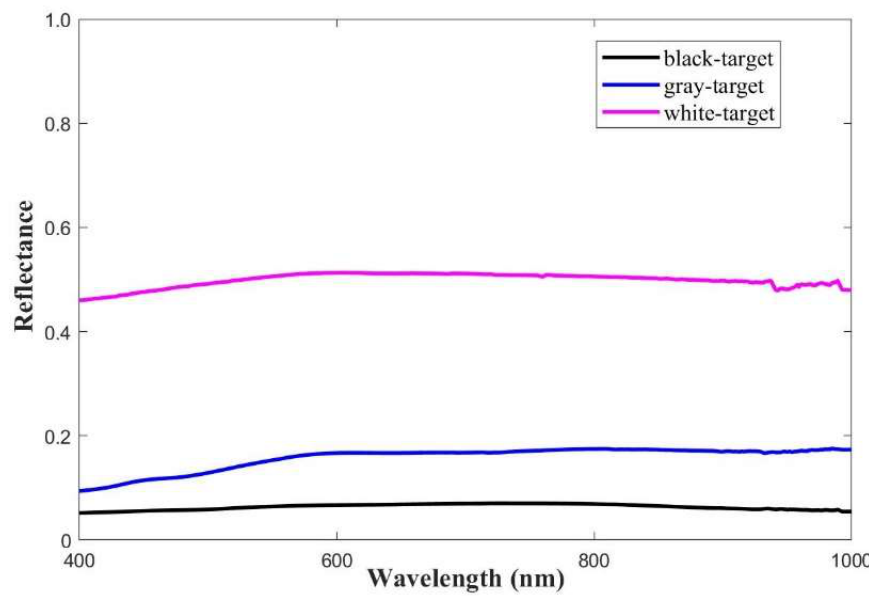
Figure 8. Spectral reflectance measurement data of gray-scale permanent targets.